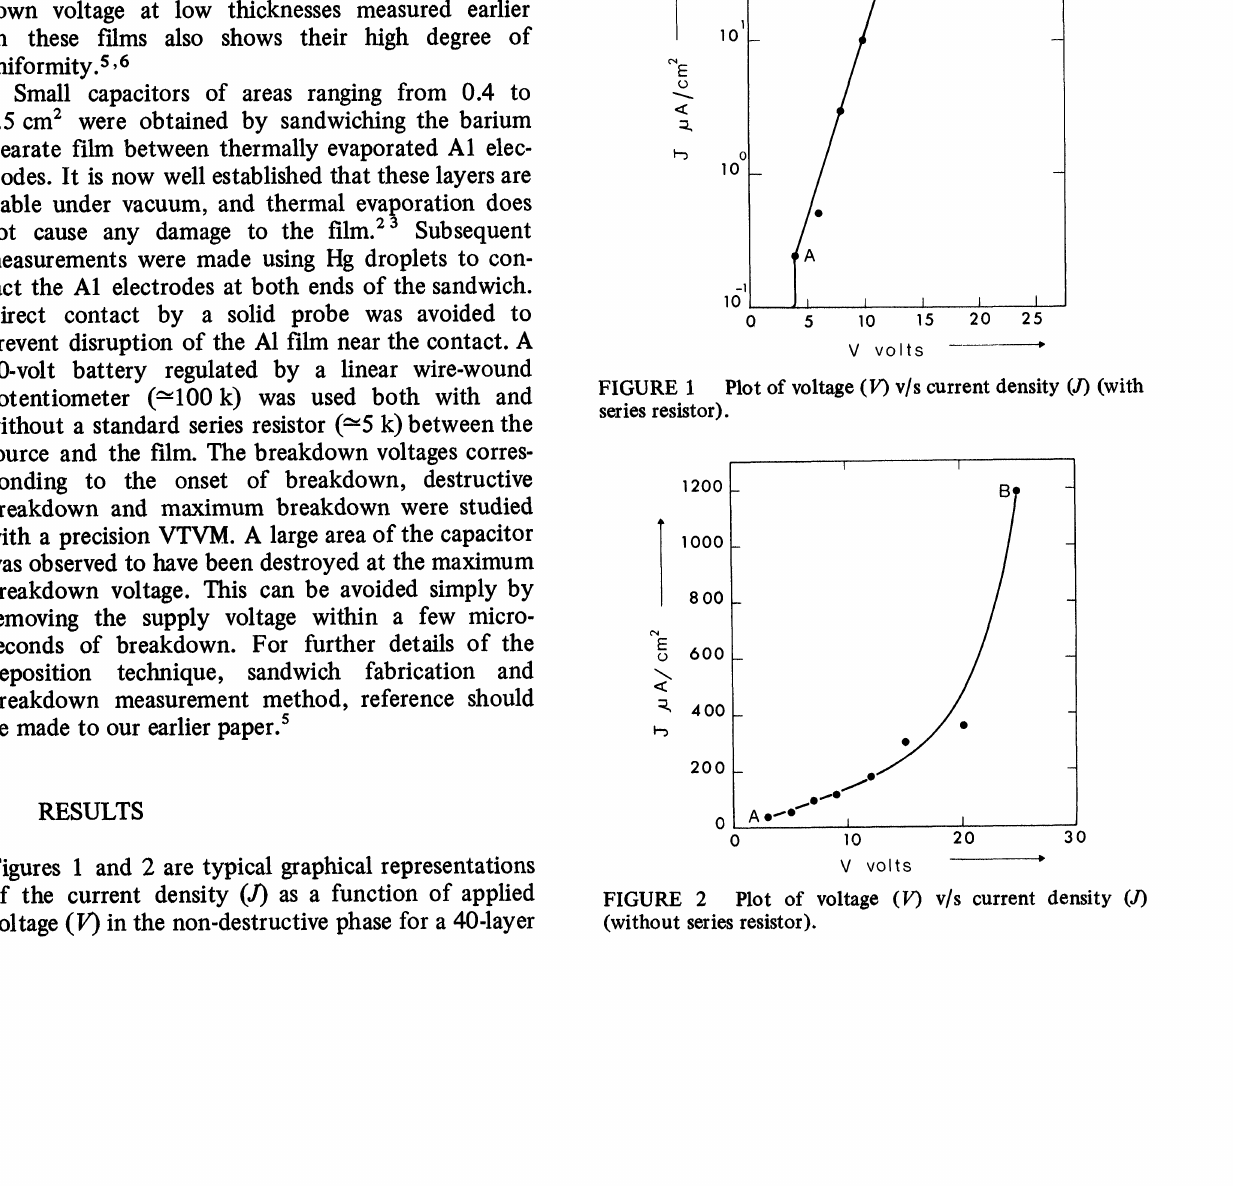
Plot of voltage (I0 v/s current density (J) (without series